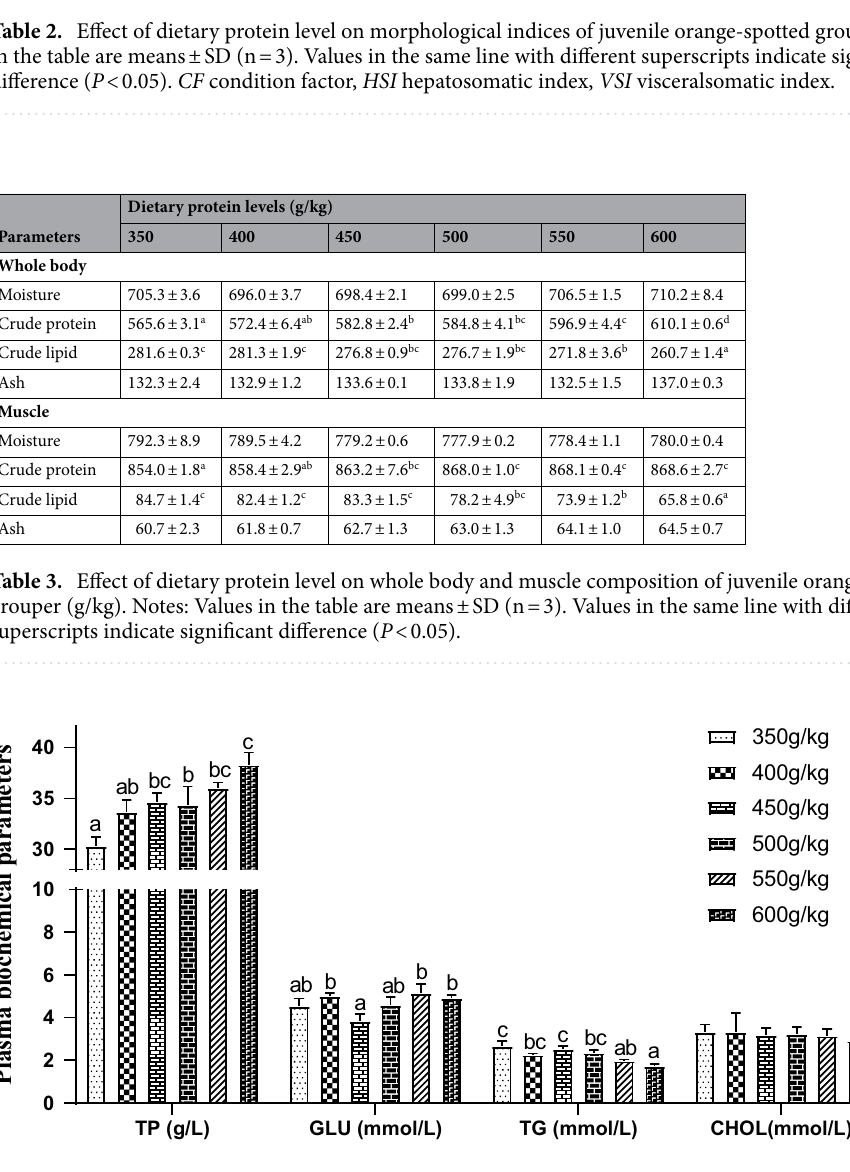
Figure 2. Effect of dietary protein level on plasma biochemical parameters of juvenile orange-spotted grouper. Values are means ± SD (n = 3). Different letters assigned to the bars represent significant differences using Duncan’s multiple comparison ( P < 0.05). TP total protein, GLU glucose, TG triglyceride, CHOL